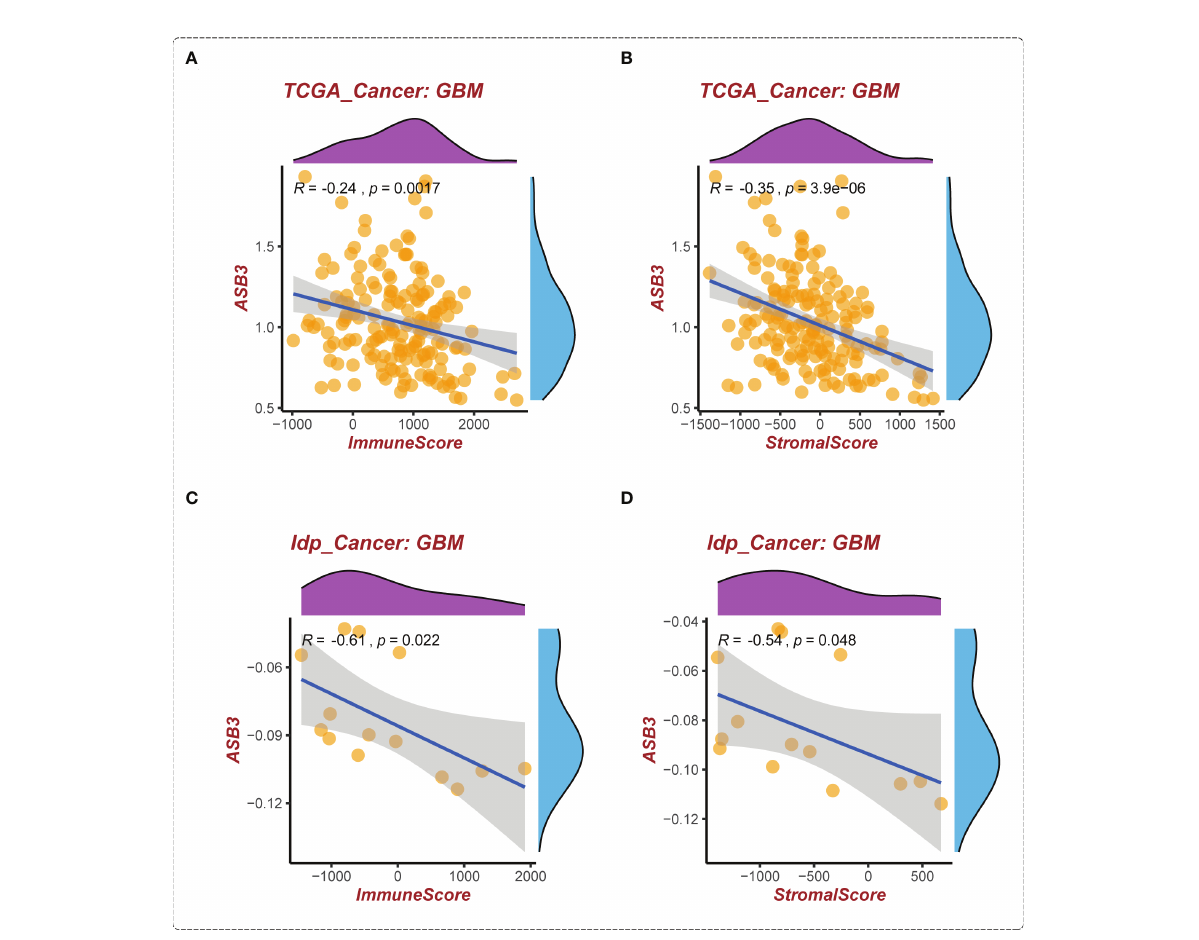
FIGURE 6 The correlation of ASB3 expression and TME in GBM. (A) Correlation between ASB3 and immune score in TCGA GBM data. (B) Correlation between ASB3 and stromal score in TCGA GBM data. (C) Correlation between ASB3 and immune score in independent GBM data. (D) Correlation between ASB3 and stromal score in independent GBM